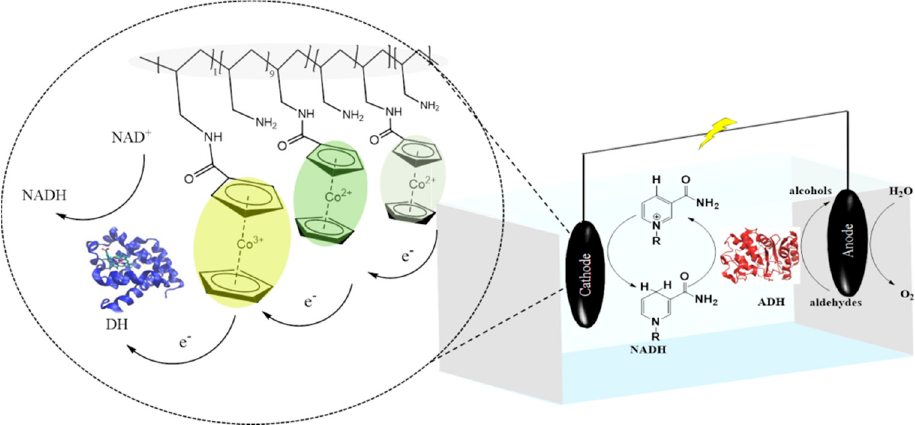
Figure 2. A schematic of the designed system for the electrochemical regeneration of NADH [57] .